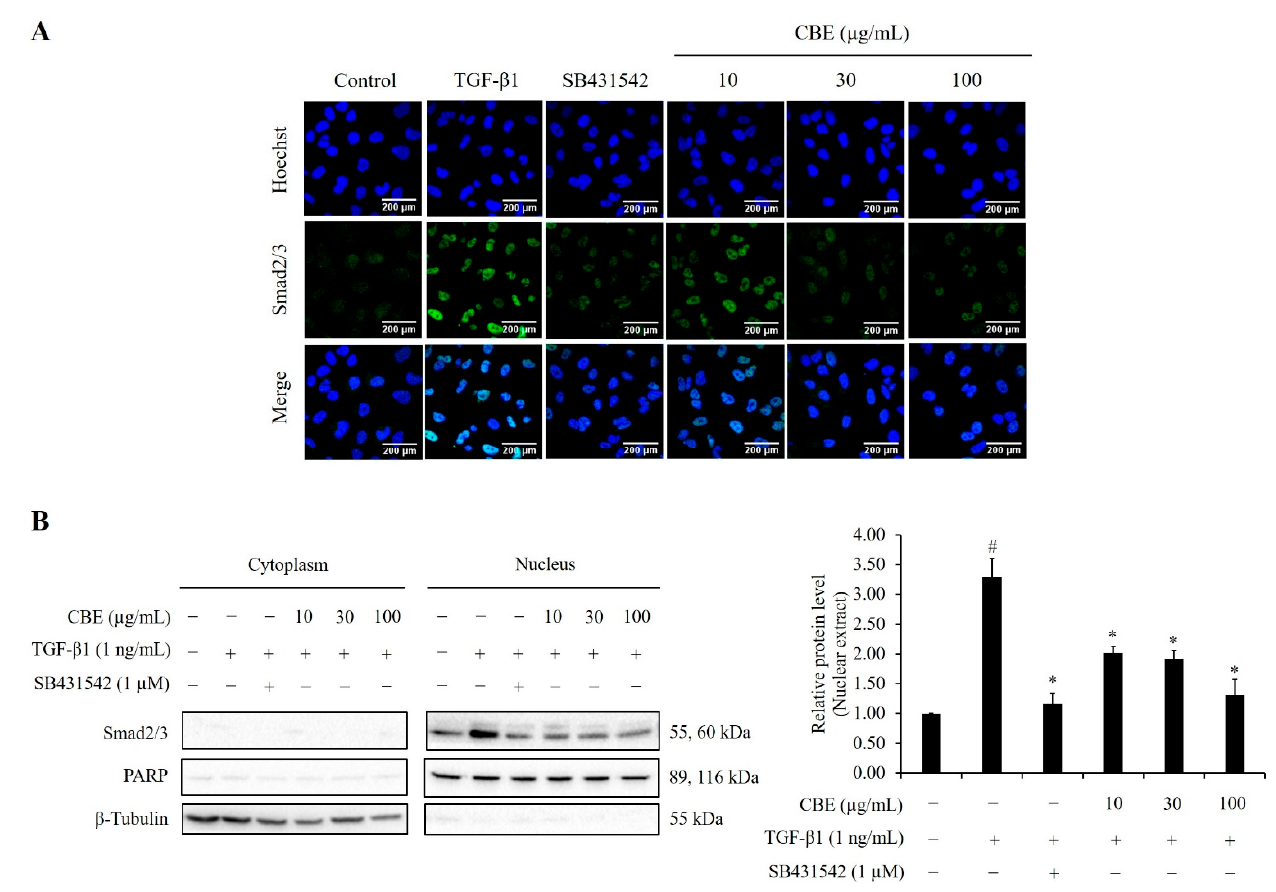
Figure 7. Effect of CBE on Smad2/3 nuclear translocation. Cells were pre-treated with CBE and SB431542, then stimulated with TGF- β 1 for an additional 1 h. ( A ) Smad2/3 nuclear translocation was monitored by immunofluorescence analysis. ( B ) Smad2/3 localization was observed by cytoplas- mic/nuclear fractionation assay. β -Tubulin and PARP were used as a control for the cytoplasmic and nuclear fraction, respectively. Data are mean values ± SD ( n = 3). # p < 0.05 versus the TGF- β 1-treated group. * p < 0.05 compared to the TGF- β 1-treated group. CBE, Cinnamomum bejolghota extract; SD, standard deviation.